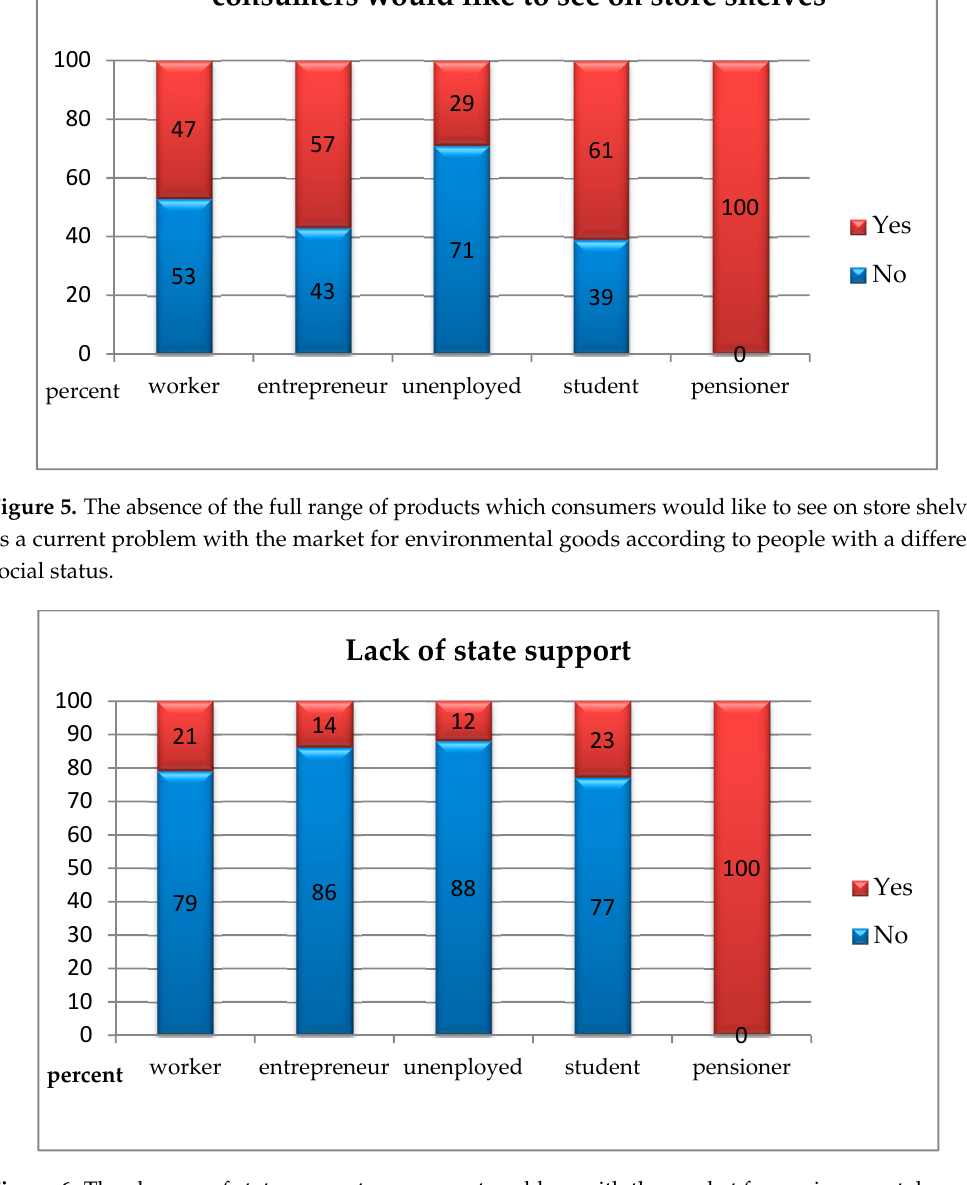
Figure 6. The absence of state support as a current problem with the market for environmental goods according to people with a different social status.